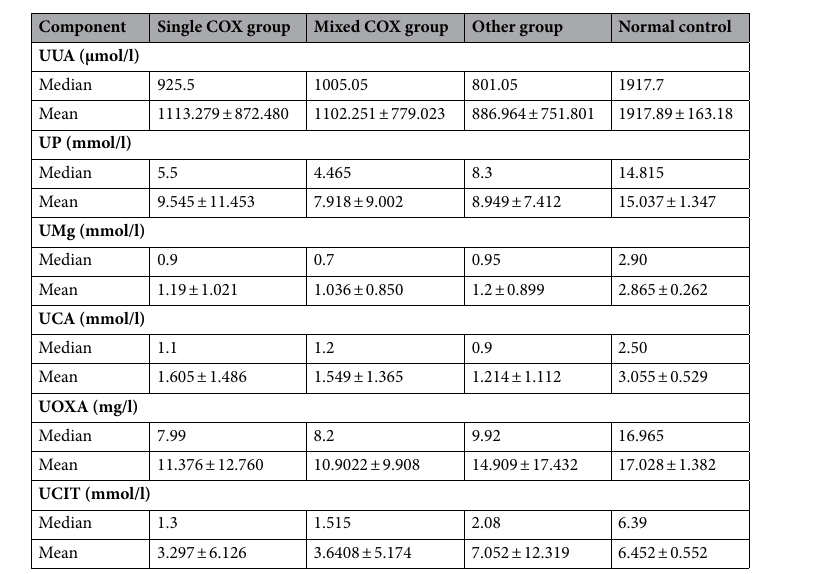
Table 2. The median and mean value of urinary components in each group. UUA urinary uric acid, UP urinary phosphorus, UMg urinary magnesium, UCA urinary calcium, UOXA uric oxalic acid, UCIT urinary citric